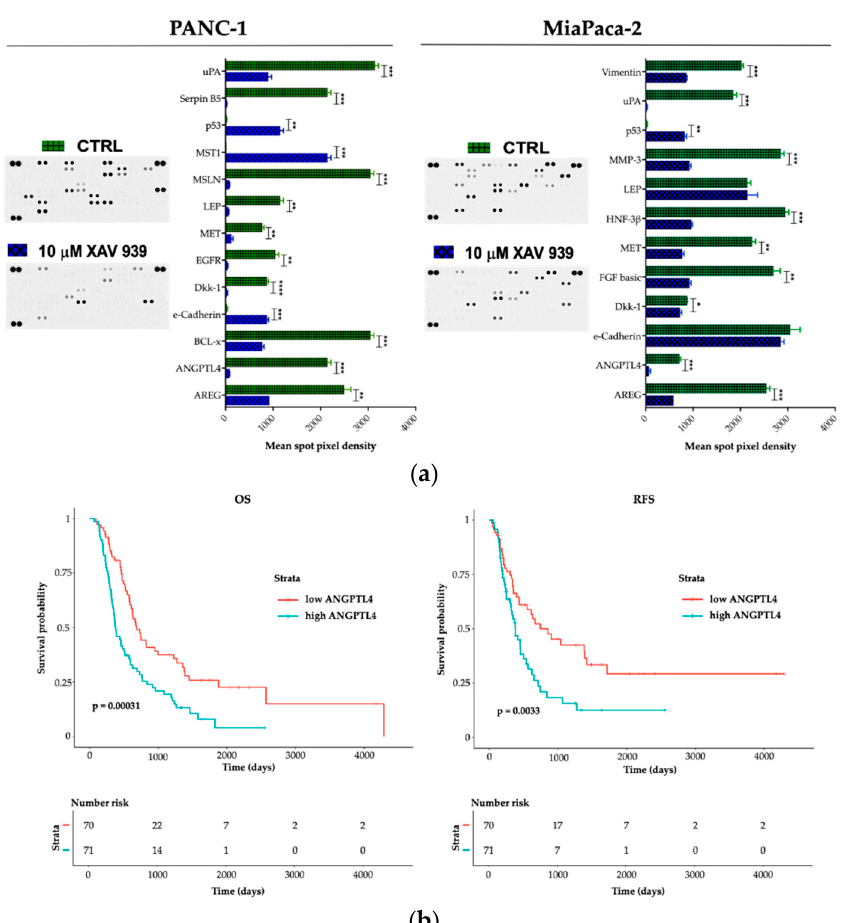
Figure 10. ( a ) A human XL oncology array of 84 human cancer-related protein was performed on PANC-1 and MIAPaCa-2 CM before and after treatment with XAV-939 (10 µM) for 48 h. Array spots were analyzed with ImageJ Lab 1.51 Software and normalized to positive control signal intensities. Graph bars represent the pixel density of the detected cancer-related proteins in two independent experiments. Values are expressed as mean ± SD of ten independent experiments. * p < 0.05; ** p < 0.05; and *** p < 0.001; **** p < 0.0001, versus control. ( b ) Survival function of ANGPTL4 high versus ANGPTL4 low PDAC patients.